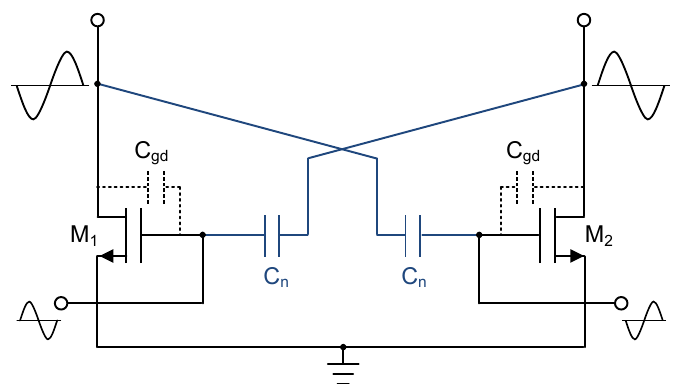
Figure 2. Conventional neutralization technique for compensating C gd .